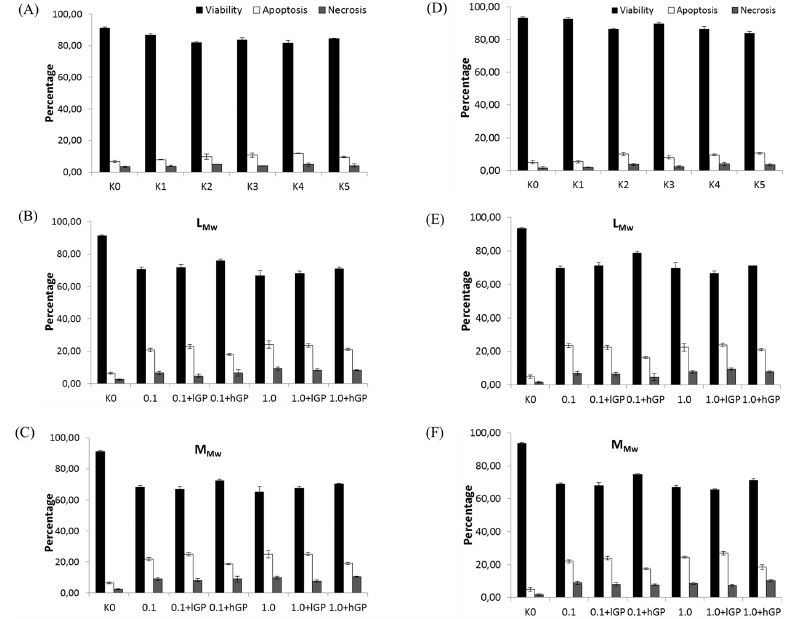
Figure 9. Results of the cytotoxicity studies (% of cell viability, apoptosis and necrosis referred to non-treated cells) using flow cytometry ( A – C ) or fluorescent microscopy assay ( D – F ) after 4 h of exposure of human vaginal epithelial cells CRL 2616 with controls (as described in Table 5) (A,D), two concentrations (0.1; 1.0 mg·mL − 1 ) of unmodified or β -GP crosslinked L Mw (B,E) or M Mw CS (C,F) (mean ± S.D.; n = 3).